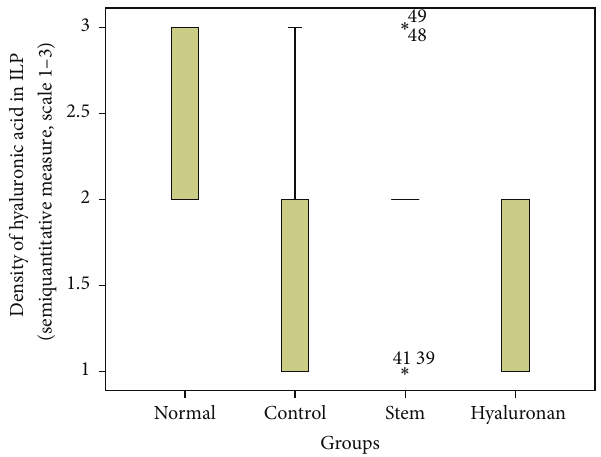
Figure 20: Level of disorganization of elastic fibers. Normal = normal/control group, control = scarred/control group, stem = stem cell group, and hyaluronan = hyaluronan group.